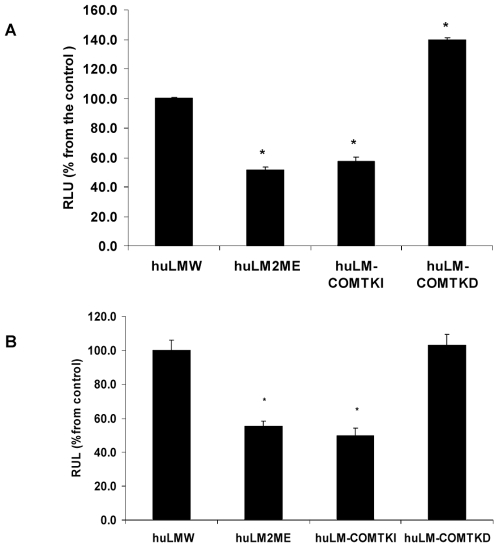
Transcriptional activity of E2 and P4 in huLM2ME, huLM-COMTKI; huLM-COMTKD and huLMW.(A) Effect of E2 on transcription activity of ERα in huLMW; huLM2ME; huLM-COMTKD; and huLM-COMTKI Cells were transfected with 50 PFU/cell of adenovirus-ERE-luc as described in
materials and methods
 section. Cells were treated with E2 (10 nM) for 48 hr. Luciferase activities were expressed as percentage of that obtained with huLMW which was given a value of 100%. Values represent the mean ± SEM of three independent experiments. (B) Effect of P4 (100 nM) on transcriptional activity of progesterone receptor in huLMW; huLM2ME; huLM-COMTKD; and huLM-COMTKI Cells were transfected with pPRE/GRE.E1b. Luc constructs as described in
materials and methods
 section. Cells were treated with P4 (100 nM) for 48 hr. Luciferase activities were expressed as percentage of that obtained with huLMW which was given a value of 100%. Values represent the mean ± SEM of three independent experiments.